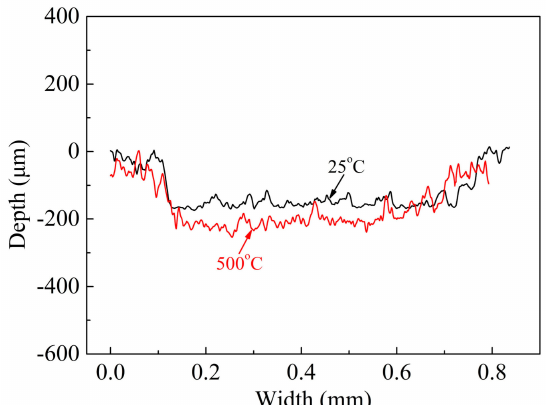
Figure 9. Three-dimensional (3D) non-contact surface mapping across the wear tracks of HEA/Ni60 coating at 25 ◦ C and 500 ◦ C in Figure